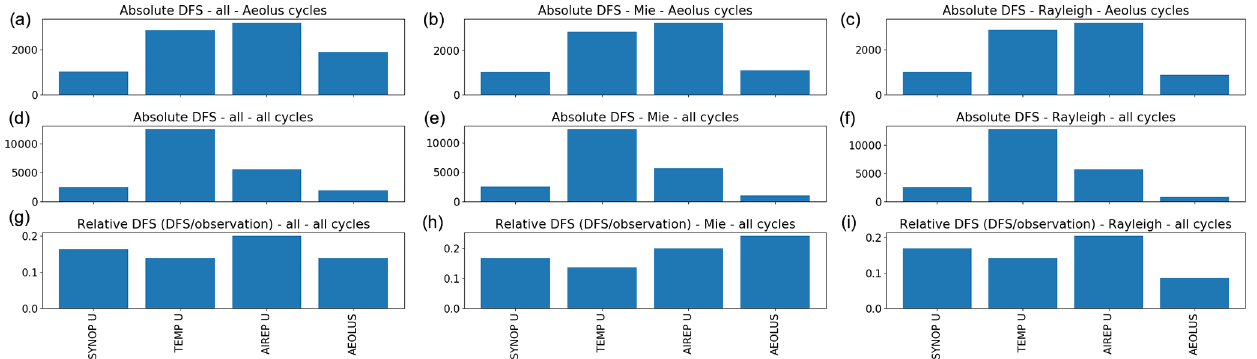
Figure 5. Degree of freedom of signal (DFS) for the experiment with all Aeolus data (a, d, g) , only Mie data (b, e, h) , and only Rayleigh data (c, f, i) for the laser B period compared with other sources of wind data. The absolute DFS for all cycles with Aeolus data is shown in the top row; the middle row shows the absolute DFS for all cycles, and the relative DFS for all cycles is shown in the bottom